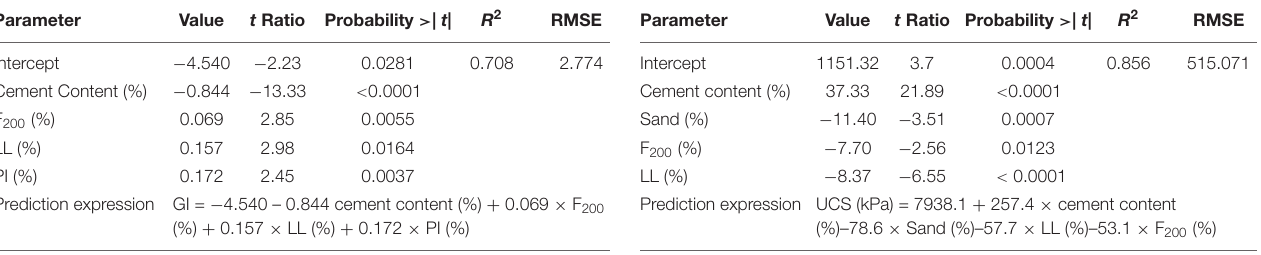
TABLE 6 | Multi-variate analysis results to predict vacuum saturated